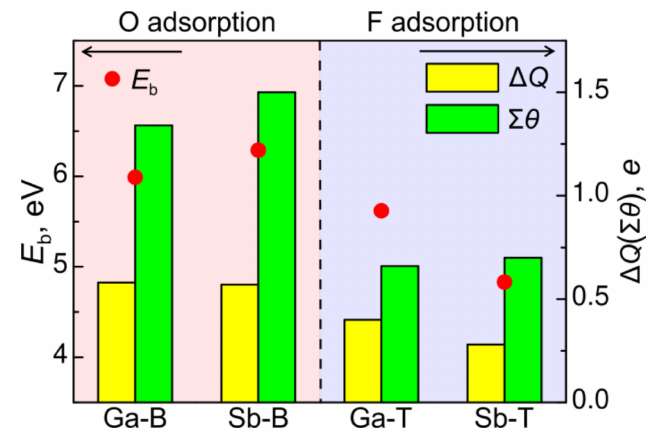
Figure 8. The binding energy ( E b ), charge transfer to adatom ( ∆ Q ), and total overlap population ( Σ θ ) for oxygen in Ga(Sb)-B and fluorine in Ga(Sb)-T positions on both GaSb(111)A and GaSb(111)B surfaces.